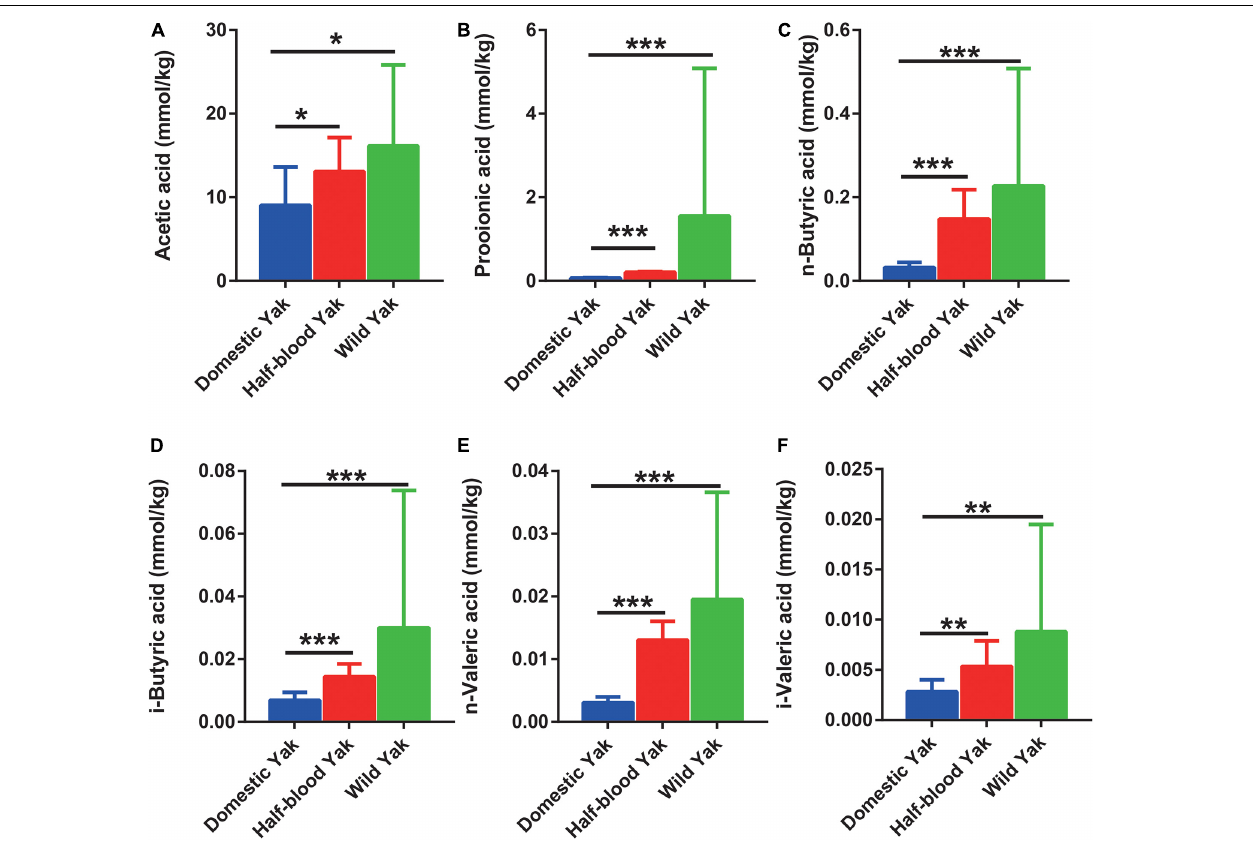
FIGURE 5 | The SCFAs concentration of gut microbiota in the three types of yaks, asterisks indicate significance level between groups ( p > 0.05, no significance; p < 0.05, *; p < 0.01, **; p < 0.001, ***). (A) Acetic acid, (B) propionic acid, (C) n-butyric acid, (D) i-butyric acid, (E) n-valeric acid, and (F) i-valeric acid.